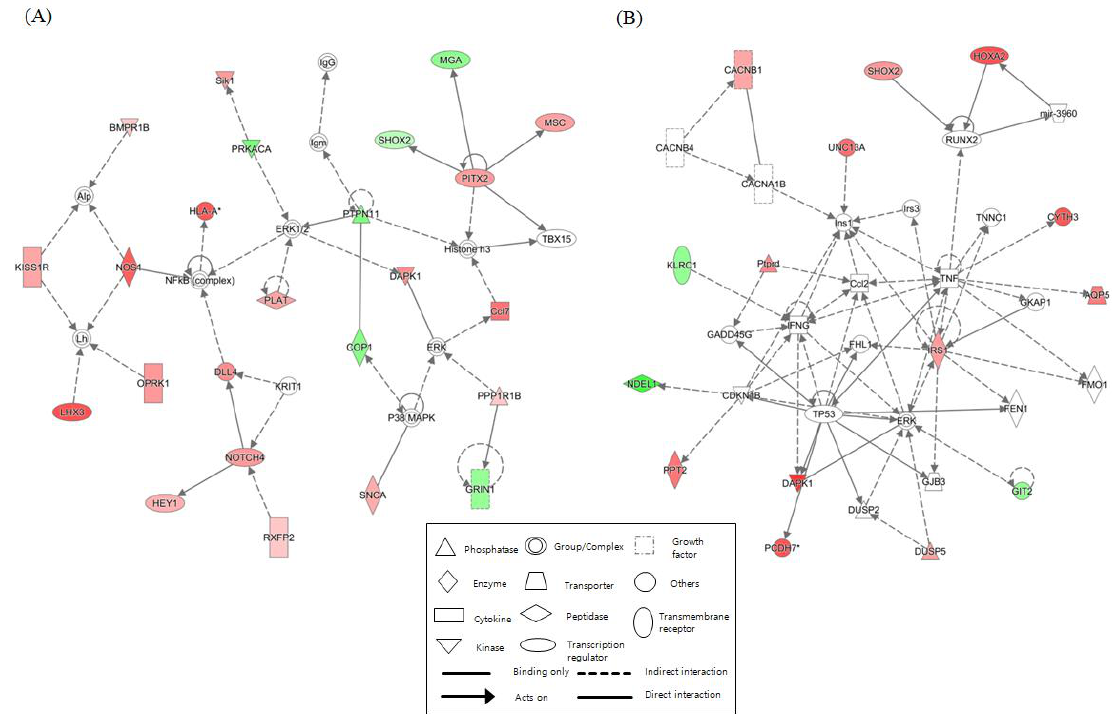
Figure 2. Top two networks based on ingenuity pathway analysis (IPA) showing interactions between the controls and the case. ( A ) Cell-to-cell signaling and interaction (control vs. DEHP). ( B ) Cancer, cell death and survival (control vs. OA). The lines between the genes represent known interactions (solid lines represent direct interactions; dashed lines represent indirect interactions). Each gene is displayed using shapes that represent the functional class of the gene product as indicated in the legend. The intensity of the red and green colors indicates the degree of up- and downregulation, respectively. A total of 25 networks ( p -scores > 18) are provided in Supplementary Table S9.